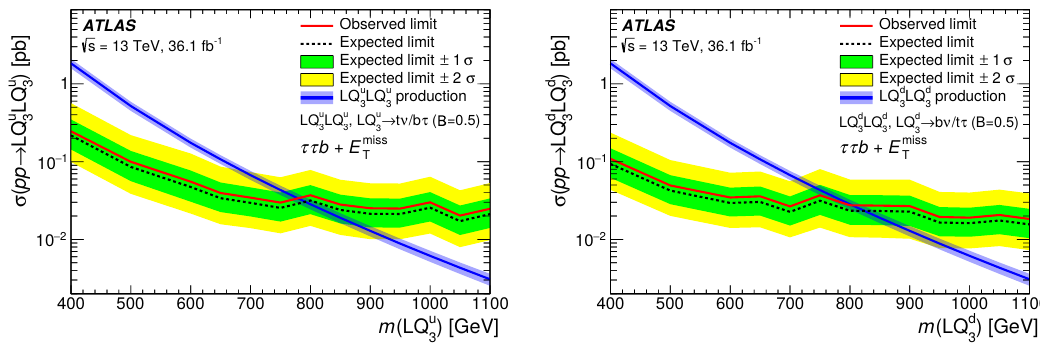
Figure 14 . Expected cross-section limits, their combined statistical and systematic uncertainties excluding the theoretical cross-section uncertainty, and observed cross-sections limits at 95% CL for B = 0 : 5 as a function of the leptoquark mass. The two channels, (cid:28) had (cid:28) had and (cid:28) ‘ (cid:28) had , are combined for the LQ u model (left) and LQ d model (right). Statistical (cid:13)uctuations are present in 3 3 the expected limits because of the low number of simulated signal events passing the comparably tight signal-region selections. The thickness of the band around the theoretical cross-section curve represents the uncertainty from PDFs, renormalization and factorization scales, and the strong coupling constant (cid:11) s